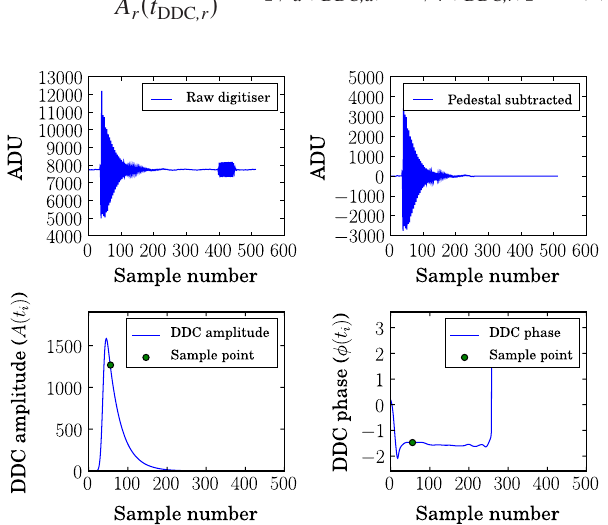
FIG. 7. Example of raw and digitally down-converted signals for a dipole C -band cavity: raw signal including the calibration tone burst (top left), raw pedestal subtracted beam generated signal only (top right), DDC amplitude (bottom left), and DDC phase (bottom right).